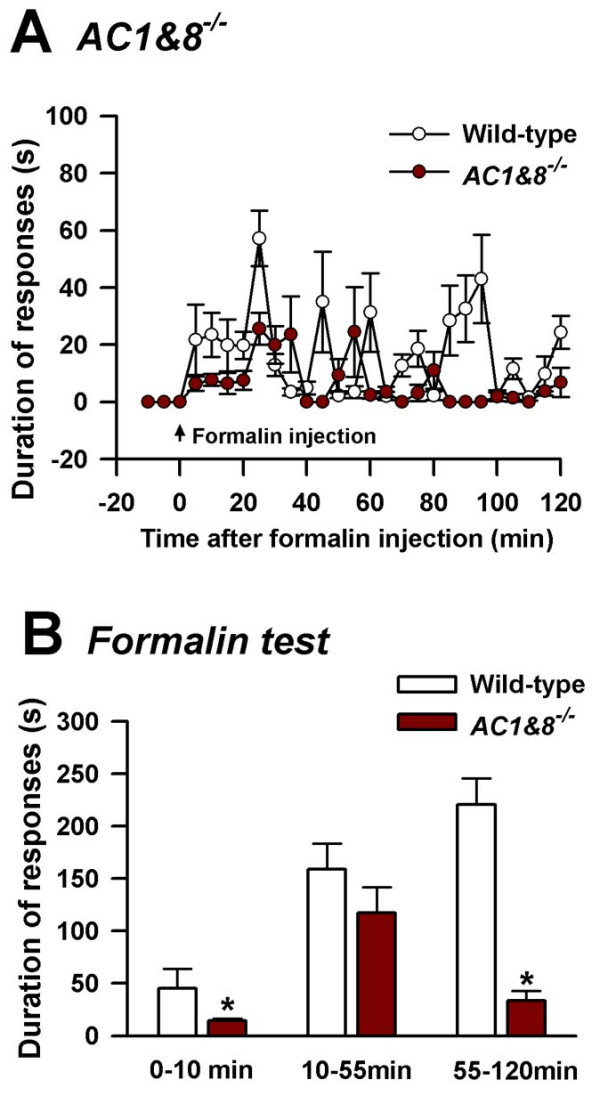
Behavioral responses to intramuscular formalin in AC1&8 DKO in comparison with wild-type mice. Cumulative response for each 5 min time is plotted on y axis as duration of responses. A. Comparison of nociceptive responses to intramuscular formalin in wild-type and AC1&8 DKO mice. Wild-type, n = 4 mice; AC1&8DKO, n = 8 mice; B. Data from experiment A is grouped as early, intermediate and late phases in comparison with wild-type mice. p < 0.05. *Significant difference from wild-type mice.